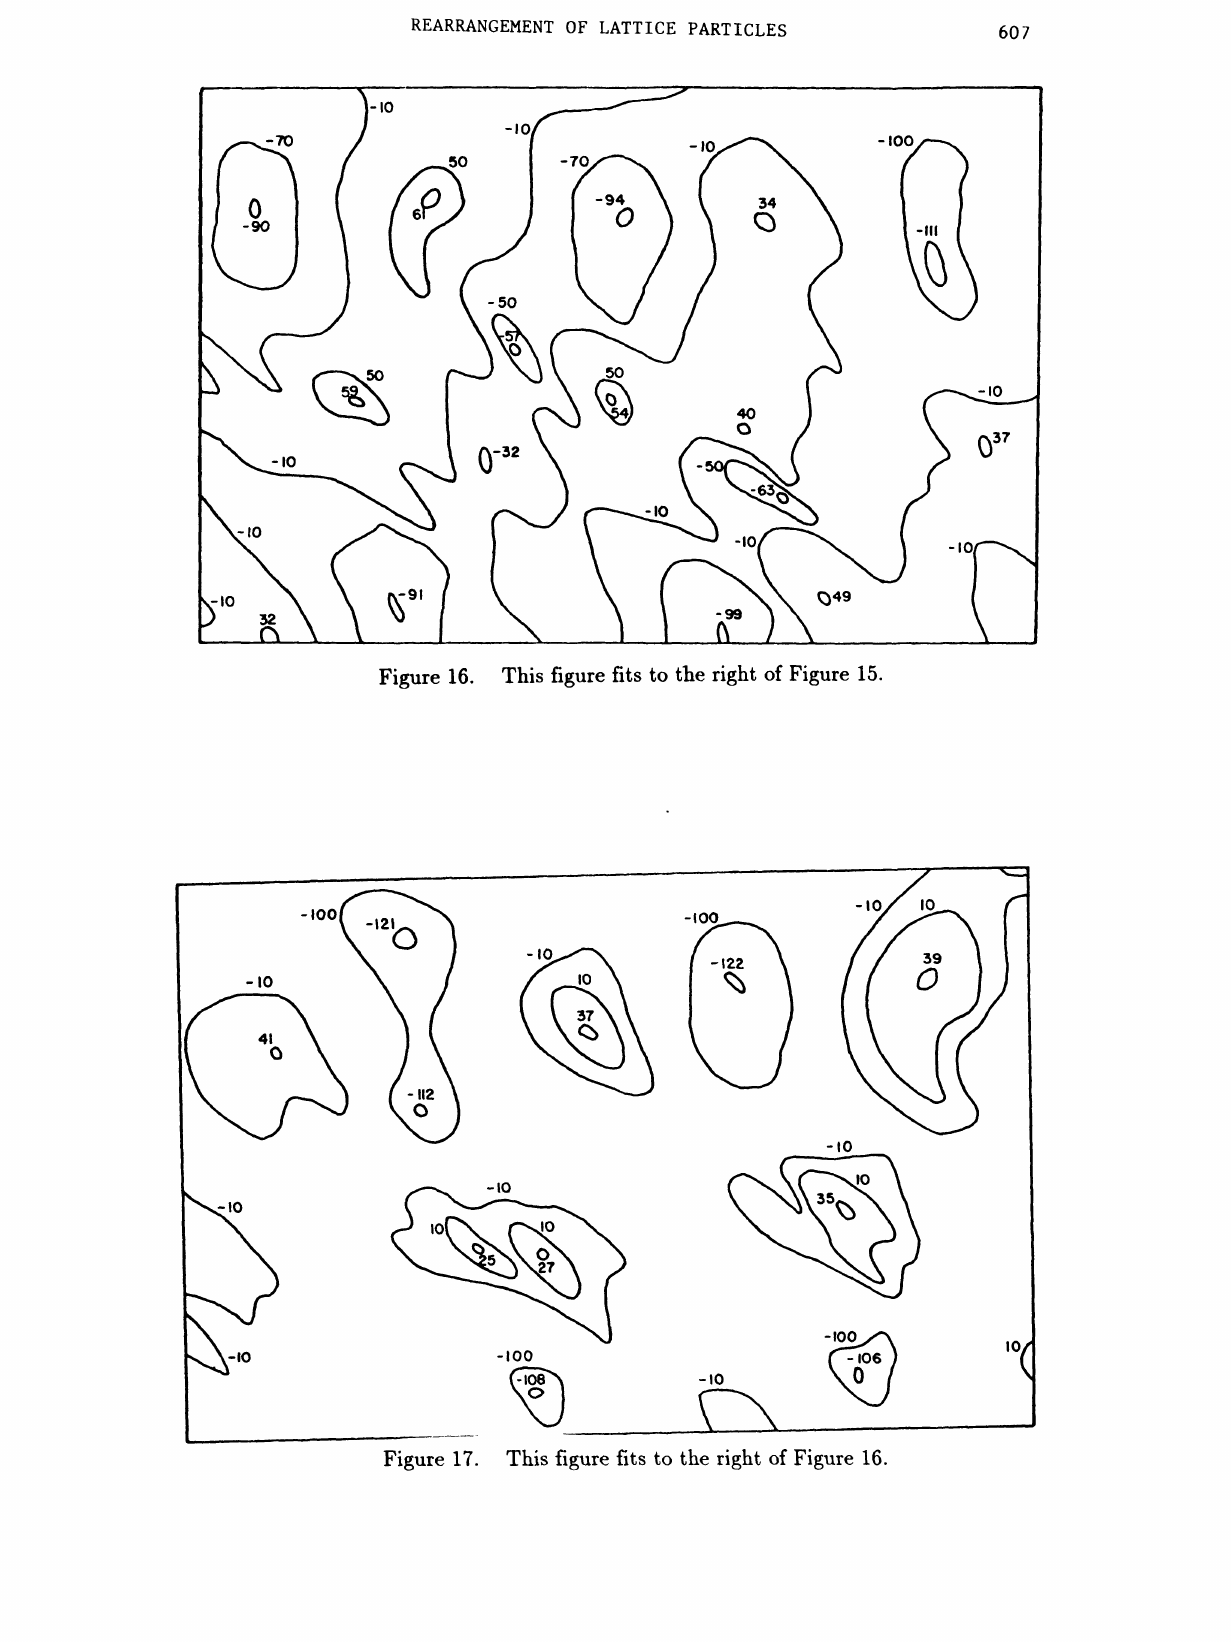
Figure 17. This figure fits to the right of Figure